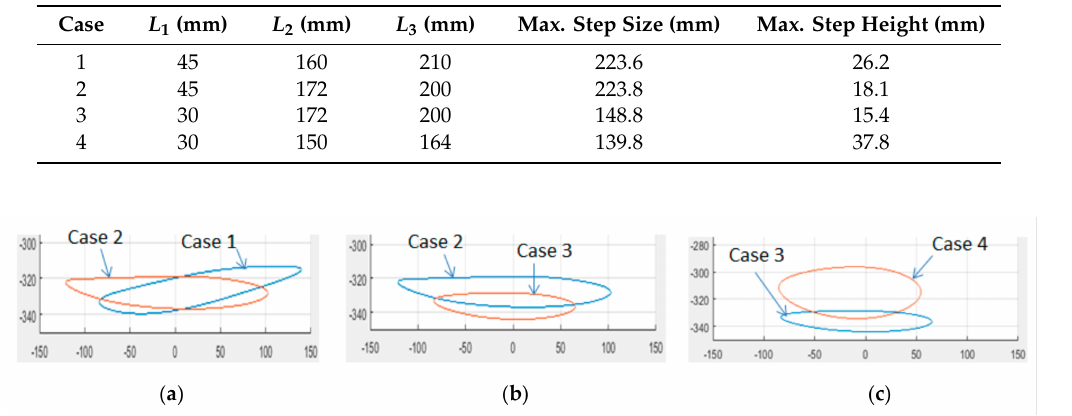
Figure 6. Actions: ( a ) inclination decreased, ( b ) step size reduced, and ( c ) step height increased.